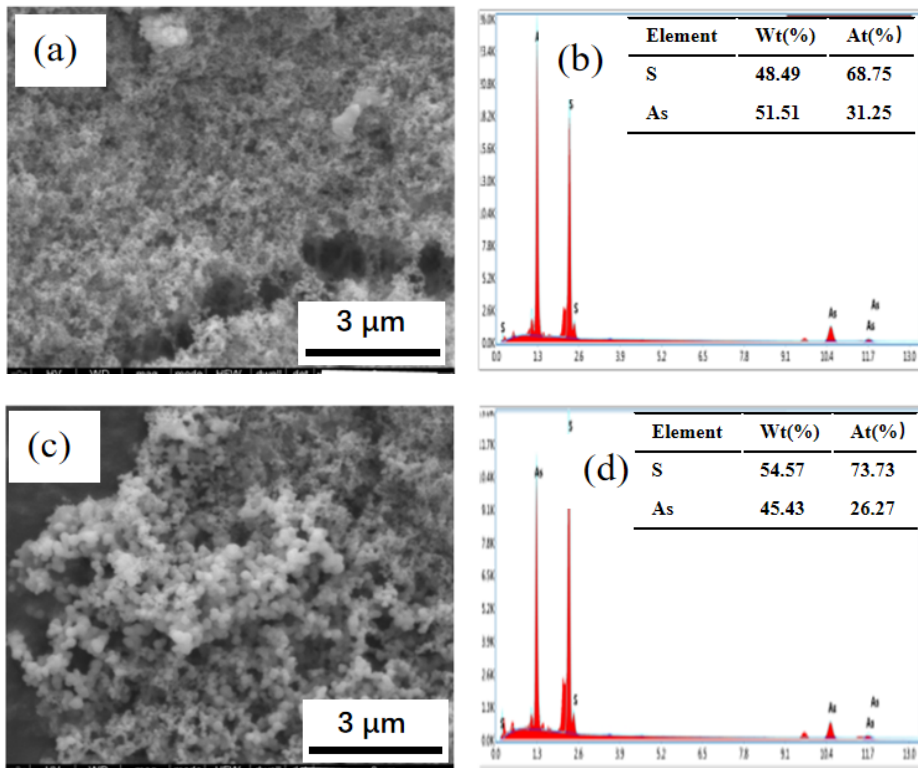
Figure 2. Picture of the precipitates: ( a ) precipitate-As(III); ( b ) precipitate-As(V).